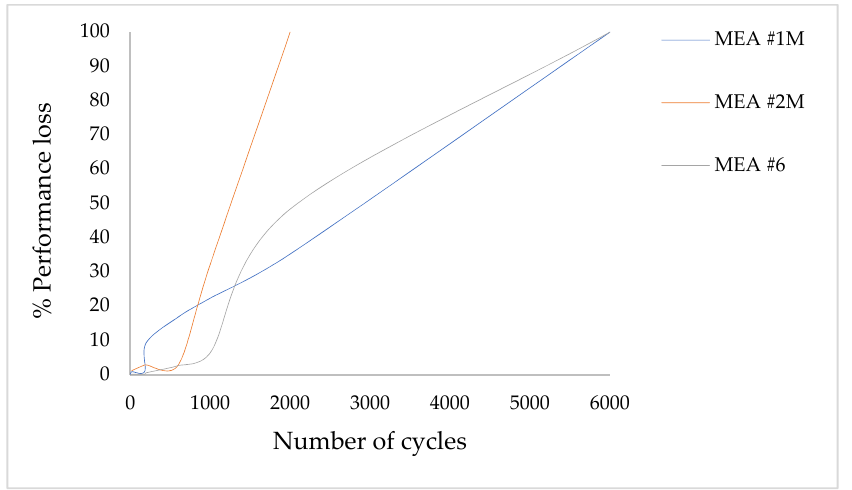
Figure 8. Percentage performance losses of the MEAs during potential cycling, measured at 200 mA/cm 2 .